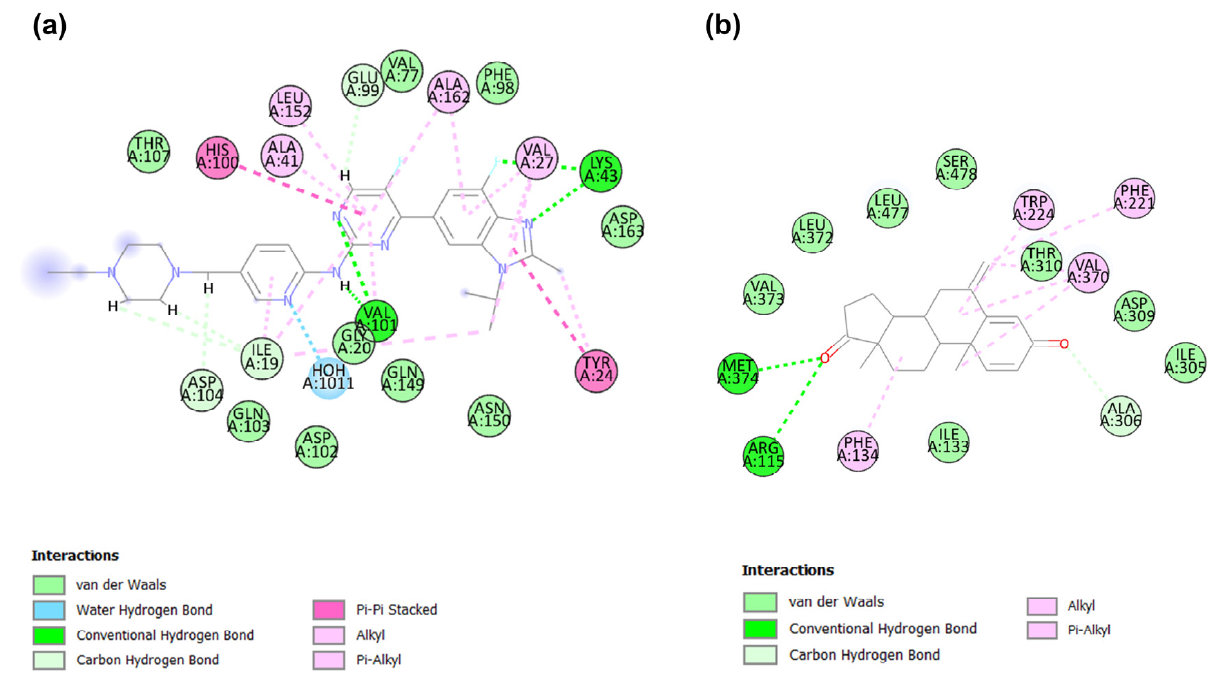
Figure 6. ( a ) shows the 2D docking interactions between abemaciclib and CDK6 (PDB ID: 5L2S). ( b ) shows the 2D interactions between exemestane and aromatase (PDB ID: 3S7S). ( b ) shows the 2D interactions between exemestane and aromatase (PDB ID: